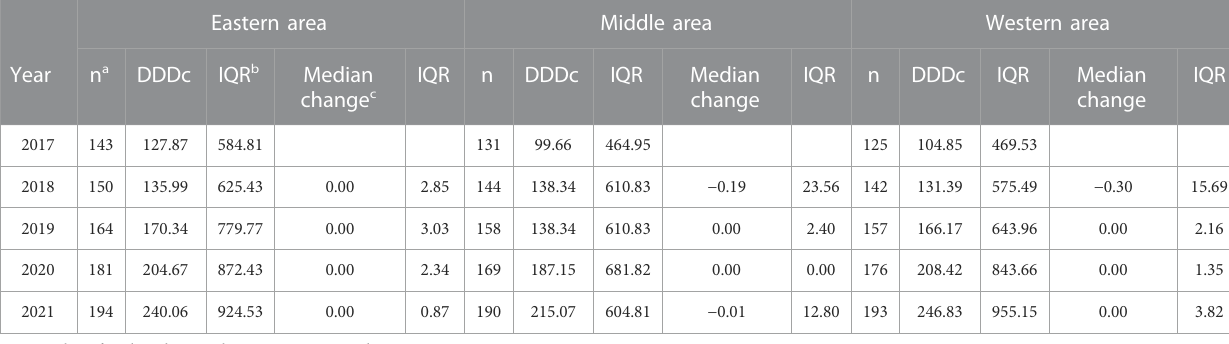
TABLE 3 Change in cost of de fi ned daily dose (DDDc) by economic area of orphan drugs in China (RMB). Eastern area Middle area Western